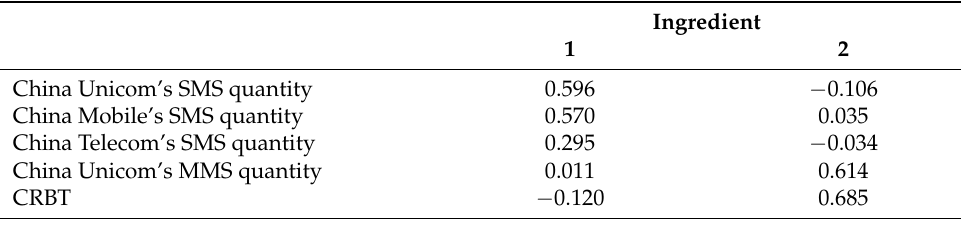
Principal component analysis applied to extract values.